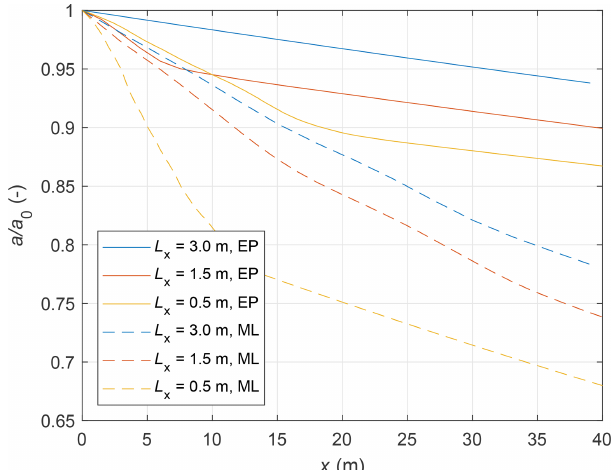
Figure 5. Computed relative wave amplitude a/a 0 for simulations with different floe sizes L x (colours), with T = 1 . 4s, a 0 = 0 . 015m, d f = 0 . 005m, C sd = 0 . 05, and ε = 0 . 6, with EP (continuous lines) and ML (dashed lines) dispersion